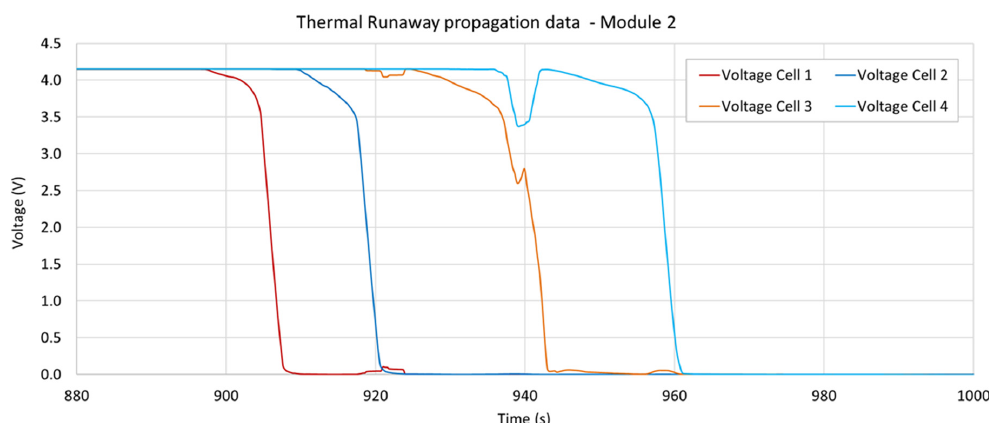
Figure 9. Voltage behavior of cells after trigger of TR. First cell exhibits a faster transition in deep thermal runaway indi- cating a more severe electrical short circuit condition. After venting of the first cell, stack pressure decreases reducing electrical short circuit severity for successive cells. Discontinuities of voltages for cells 3 and 4 are due to venting of adjacent cells. Table 2. TR propagation times based on the voltage drop measurements. Some values are missing— indicated as: Loss of Contact (LoC)—since cables contacts were lost during test due to violent gas